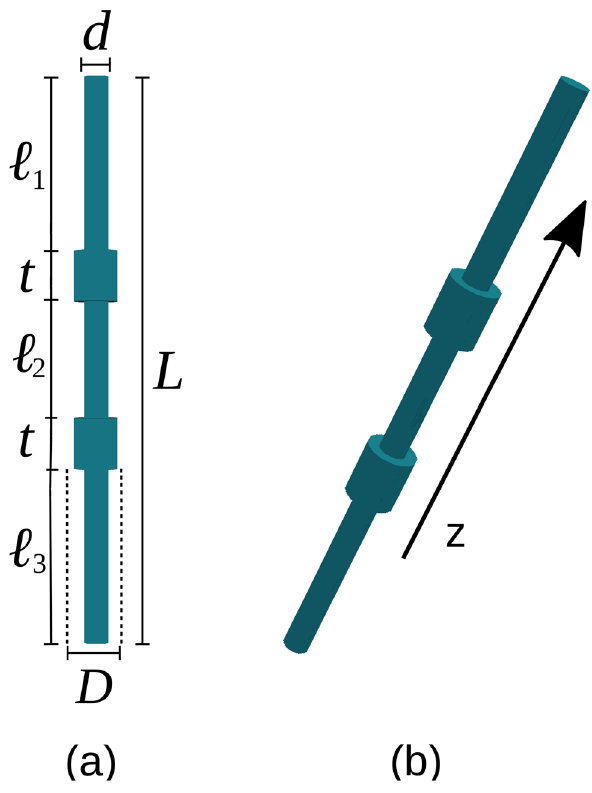
Figure 1. (a) Front view of the proposed bimodulated nanowire with the definition of its geometrical parameters. (b) 3D view of the system where its symmetry axis is parallel to the z-axis along which a magnetic field will be later